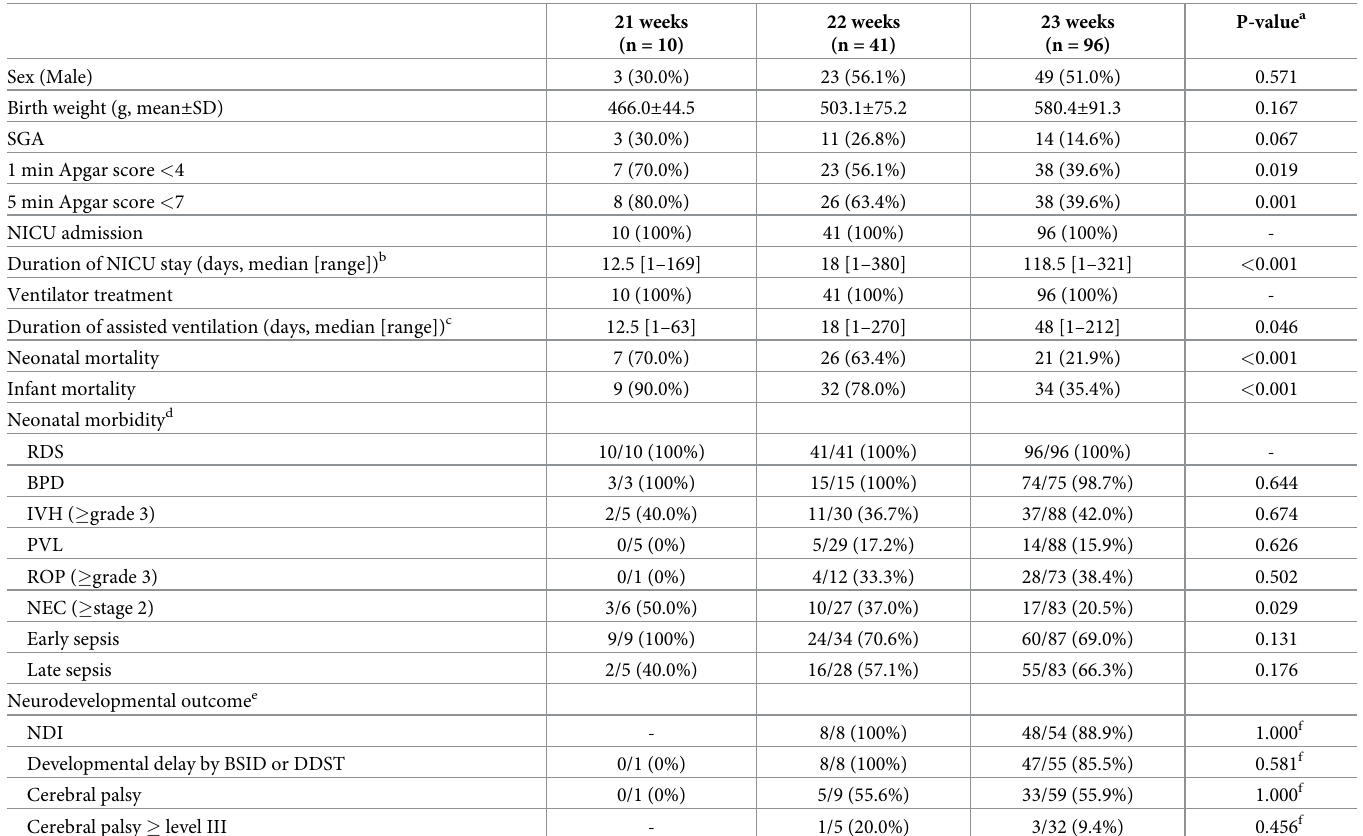
Table 2. Neonatal outcomes according to gestational age at